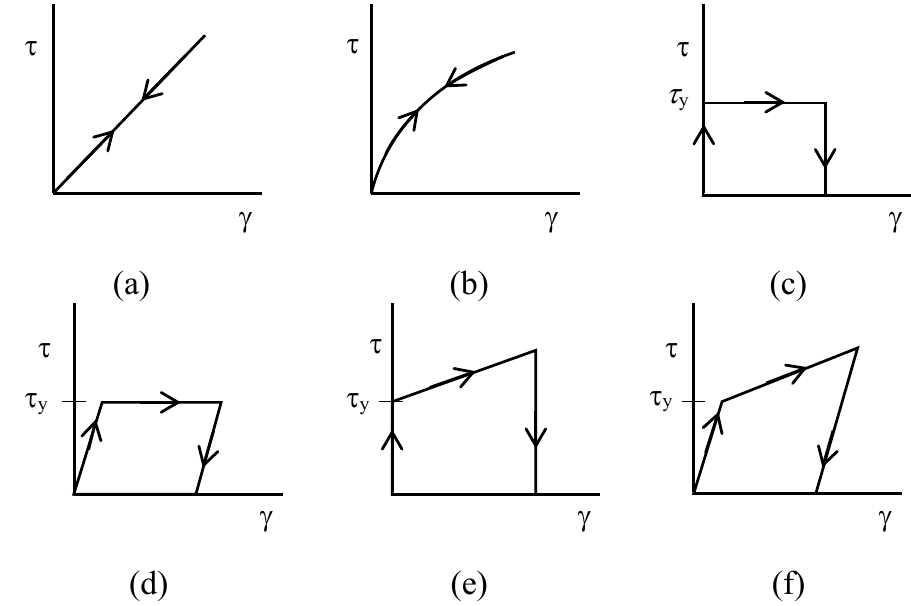
Figure 2: Typical stress-strain relation for solid bodies: (a) linear elastic (Hookean solid); (b) non-linear elastic; (c) rigid-perfectly plastic; (d) elastic-perfectly plastic (elastoplastic); (e) rigid linear hardening; (f) linear elastoplastic hardening. Modified from [15, 16]